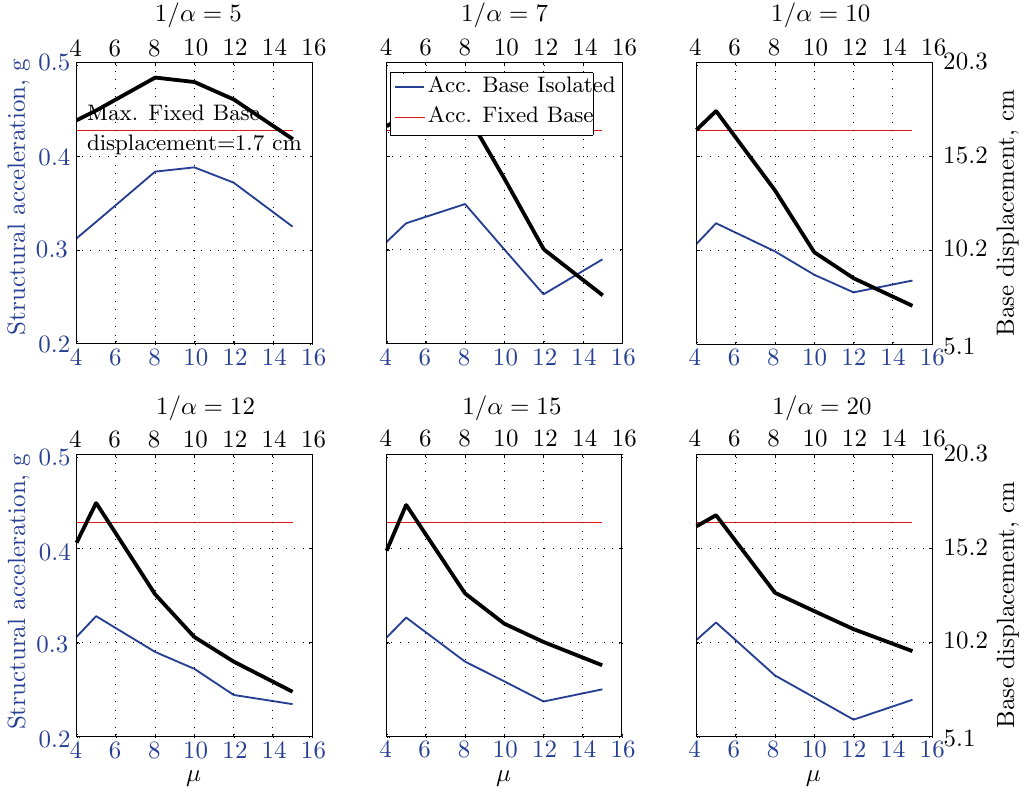
Figure 42. Peak responses of BI-structures subjected to Landers 1992 (Yermo station).